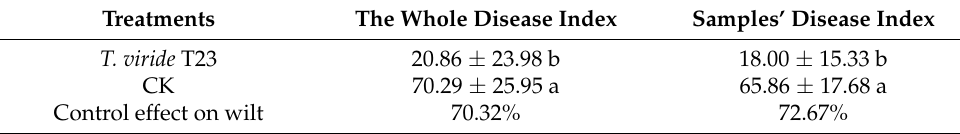
Table 1. Incidence and control effect of muskmelon wilt.